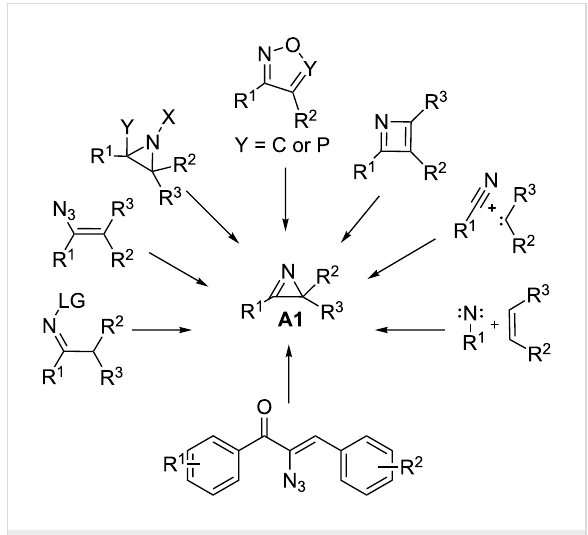
Figure 2: Various strategies for the formation of 2 H -azirine.